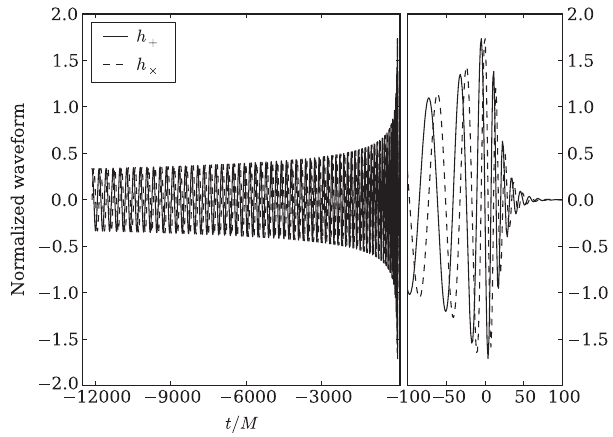
FIG. 2. Time series of a normalized (2,2) mode of an EOB waveform for an equal-mass, nonspinning black hole binary coalescence. This waveform, corresponding to about 70 gravi- tational wave cycles, is representative of the structure encoun- tered when building a surrogate